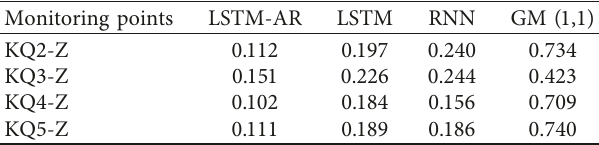
Table 9: The prediction accuracy of different models. Monitoring